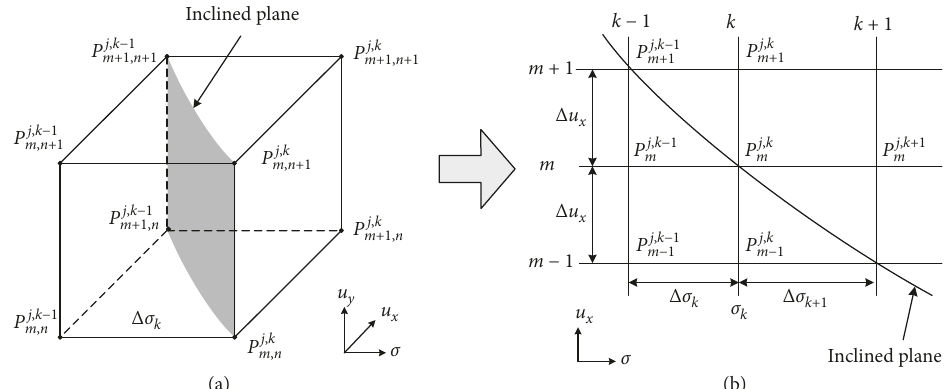
Figure 2: Finite-difference method staggered grid system. (a) Staggered grid system at inclined boundary. (b) Staggered grid system in x- directions represent